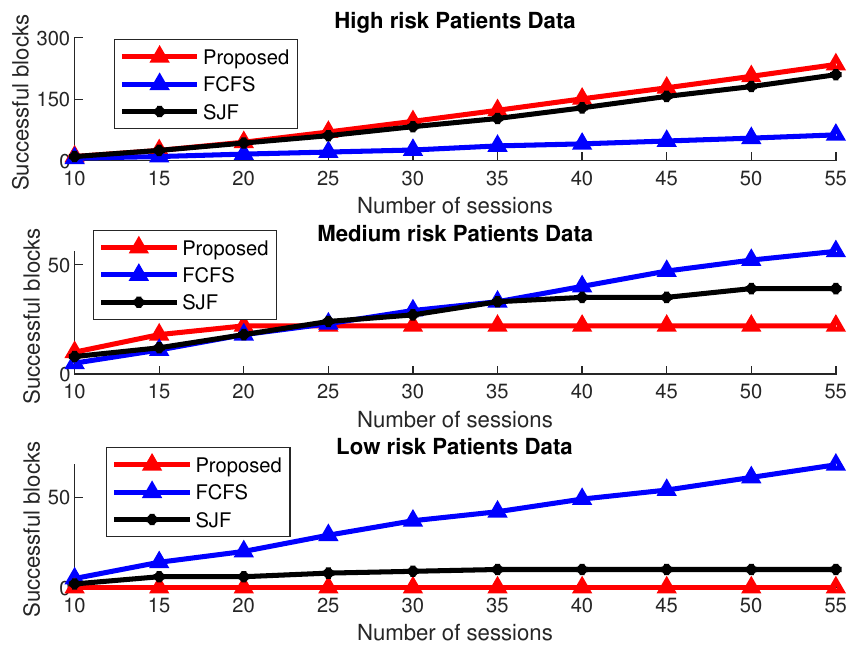
Figure 15. Successful transmission of priority data for a varying number of